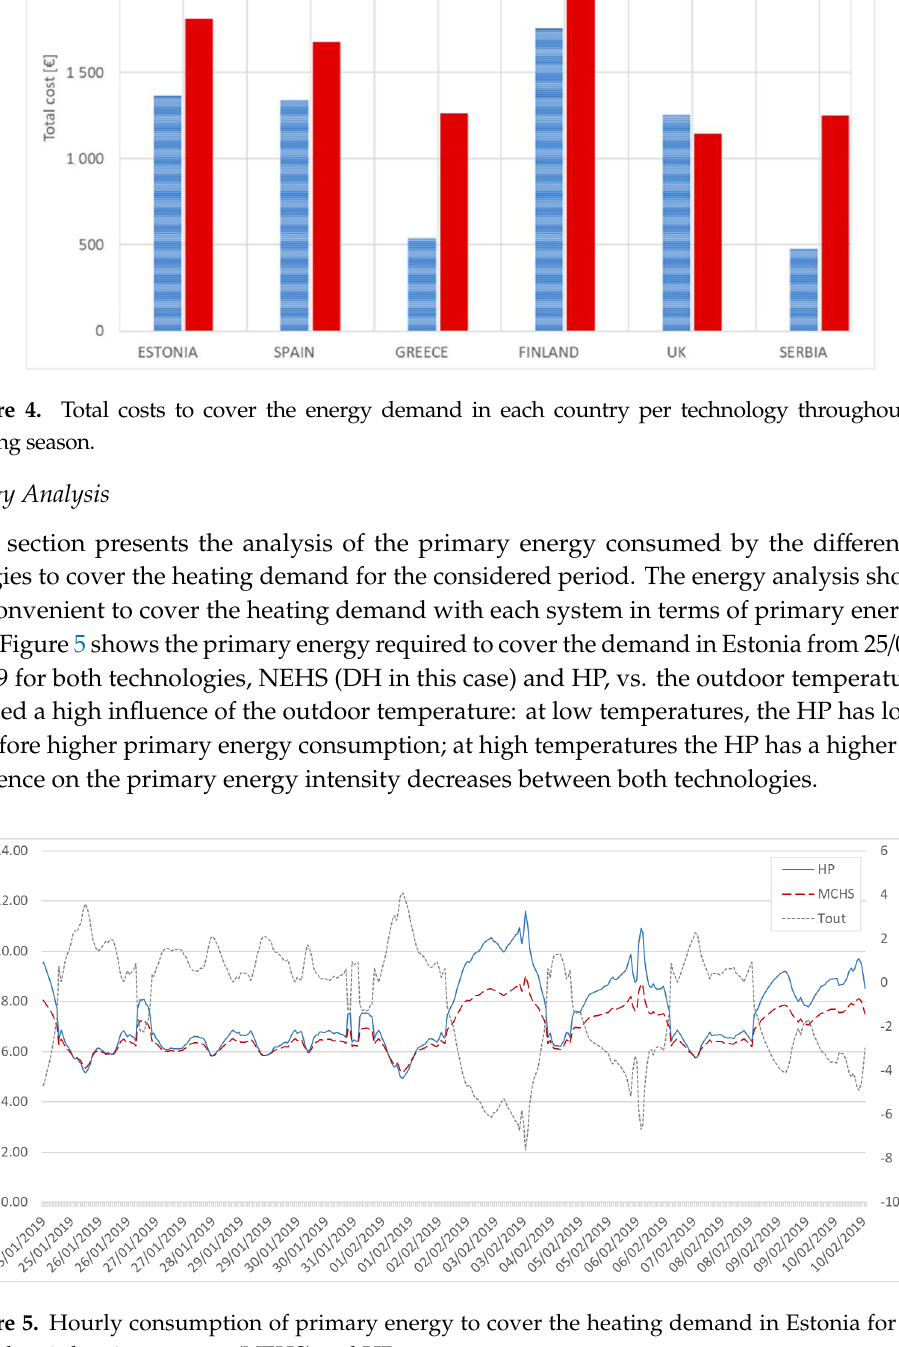
Figure 3. Hourly consumption cost for the district heating and both flat and real time price tariffs.